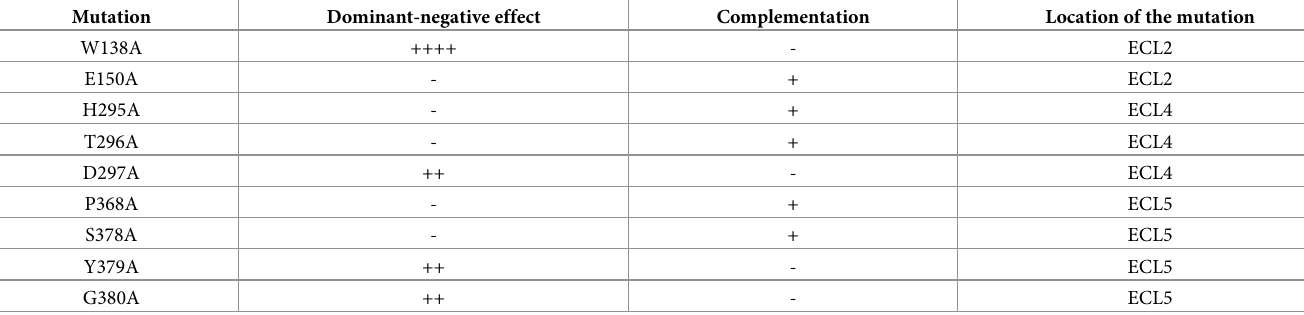
Dominant-negative effect: “++++” and “++” indicate that it takes � 60 μ M or 60~125 μ M IPTG to induce the expression of the mutant to completely block colony formation, respectively. “-” indicates the mutants do not display a dominant-negative effect. Complementation: “+” and “-” indicate that the mutant can or cannot complement an ftsW depletion strain, respectively.